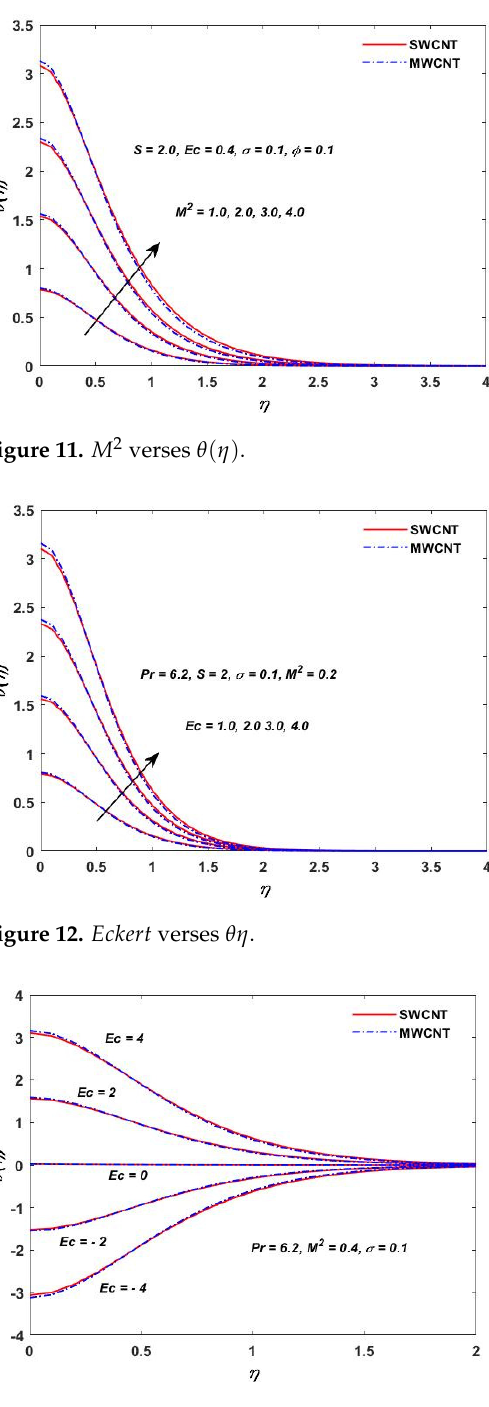
Figure 10. 𝜎 verses 𝜃(𝜂).